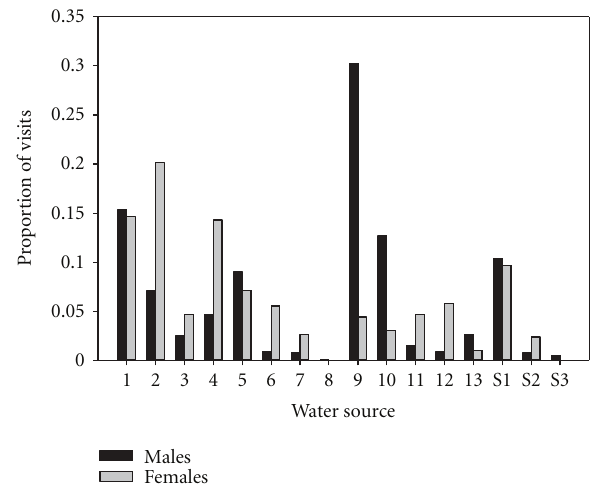
Figure 5: Proportion of visits by male and female mule deer to water sources in western Utah, USA, 2007–2011. Water sources 1 to 13 were wildlife water developments; S1 to S3 were natural and modified